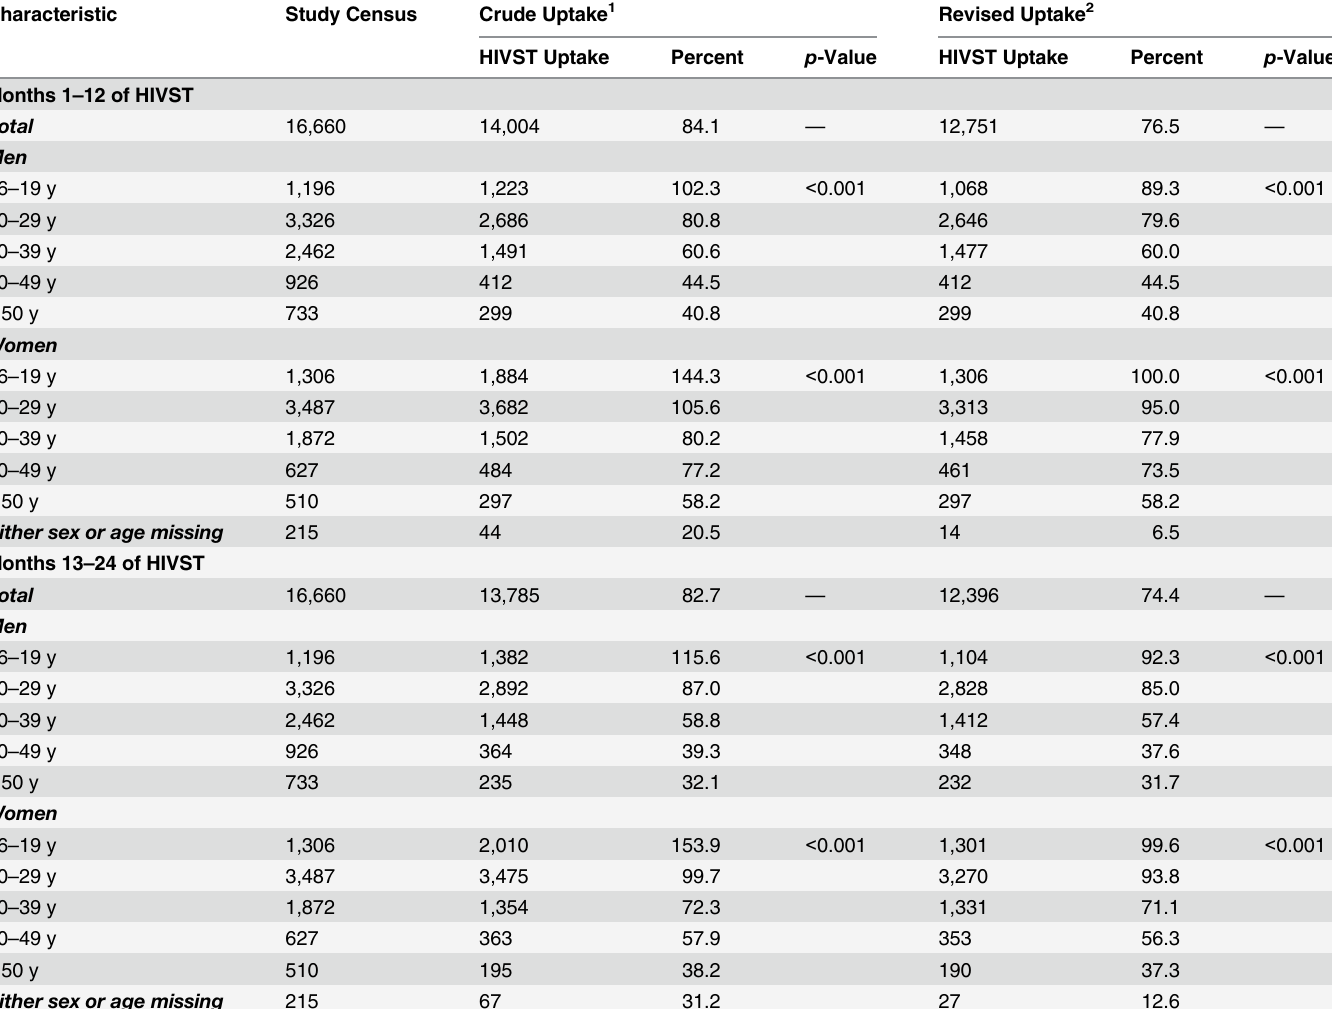
Table 2. Age-sex distribution of study population and study participants with and without adjustment by study census maximum denominators in age-sex-neighbourhood subgroups. Characteristic